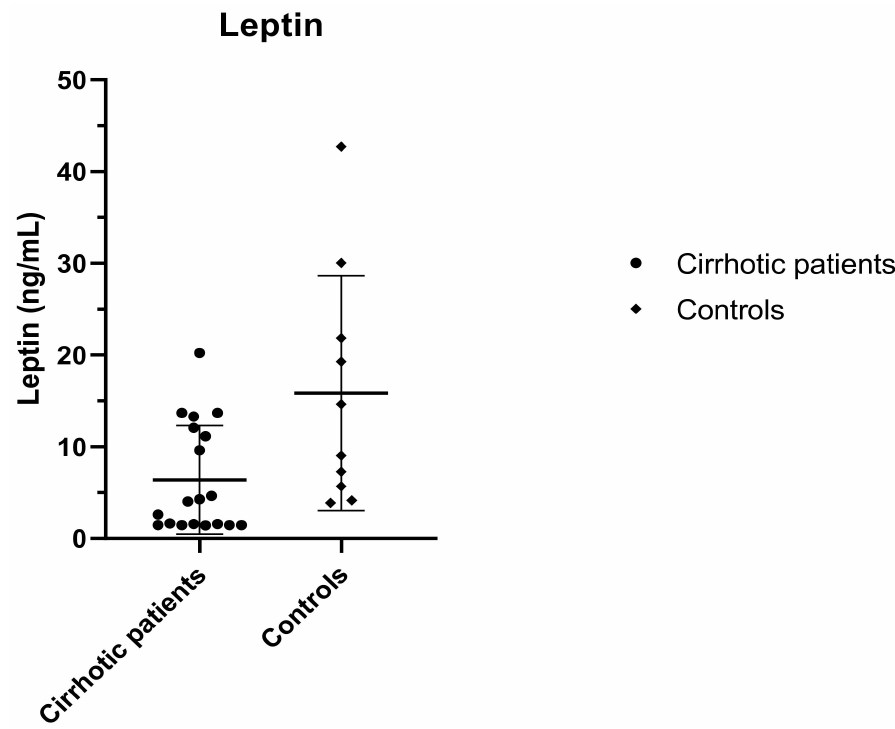
Livers 2022 , 2 , FOR PEER REVIEW